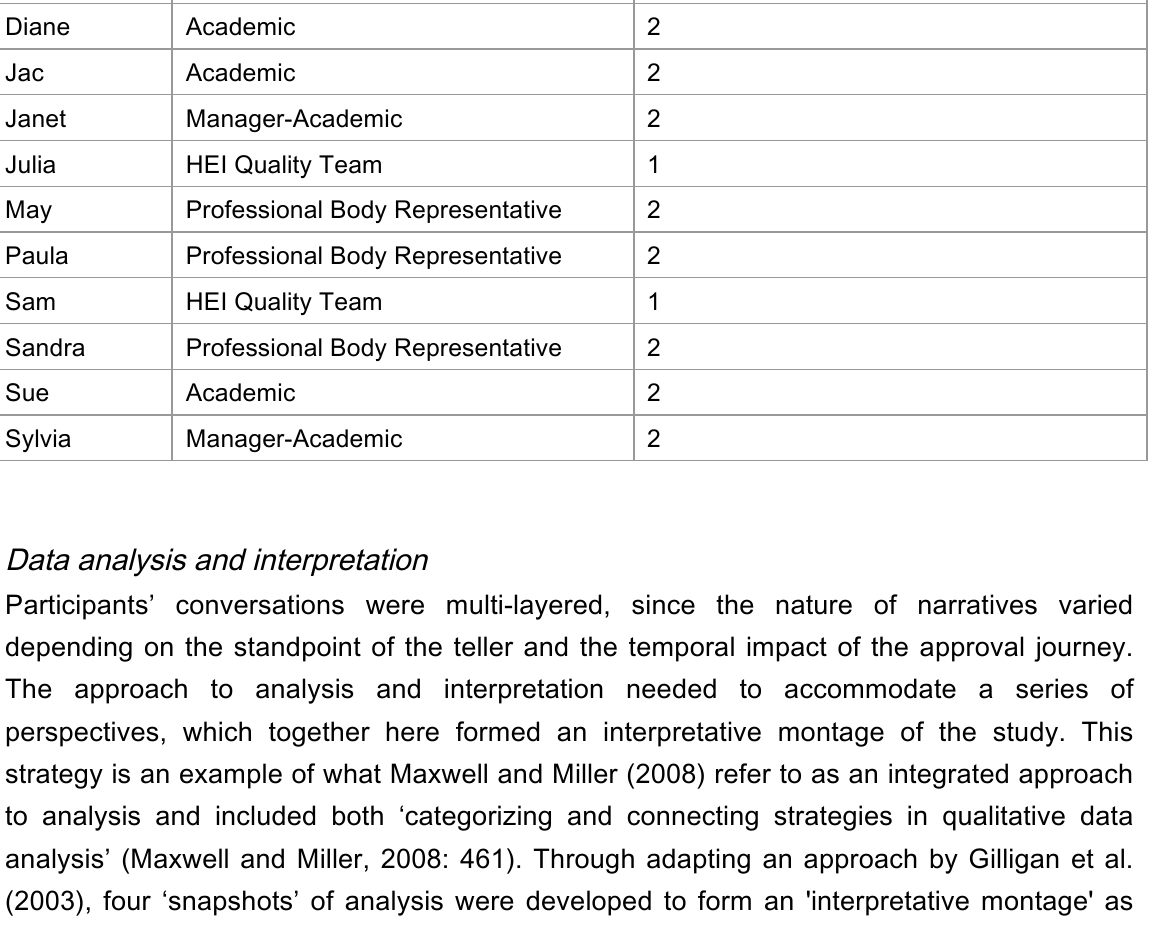
Number of interview